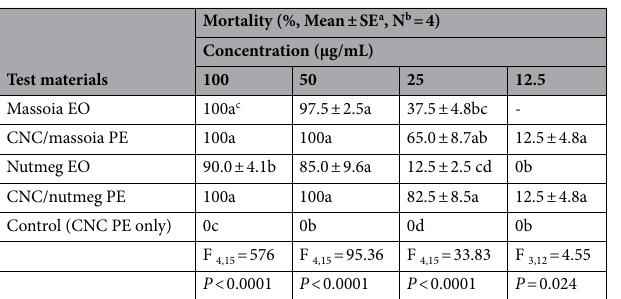
Table 4. Larvicidal activity of CNC-stabilized PEs of massoia and nutmeg EOs against Ae. albopictus. a Standard error of the mean; b Replication number; c Means within a column followed by the same letters are not significantly different (Scheffe’s